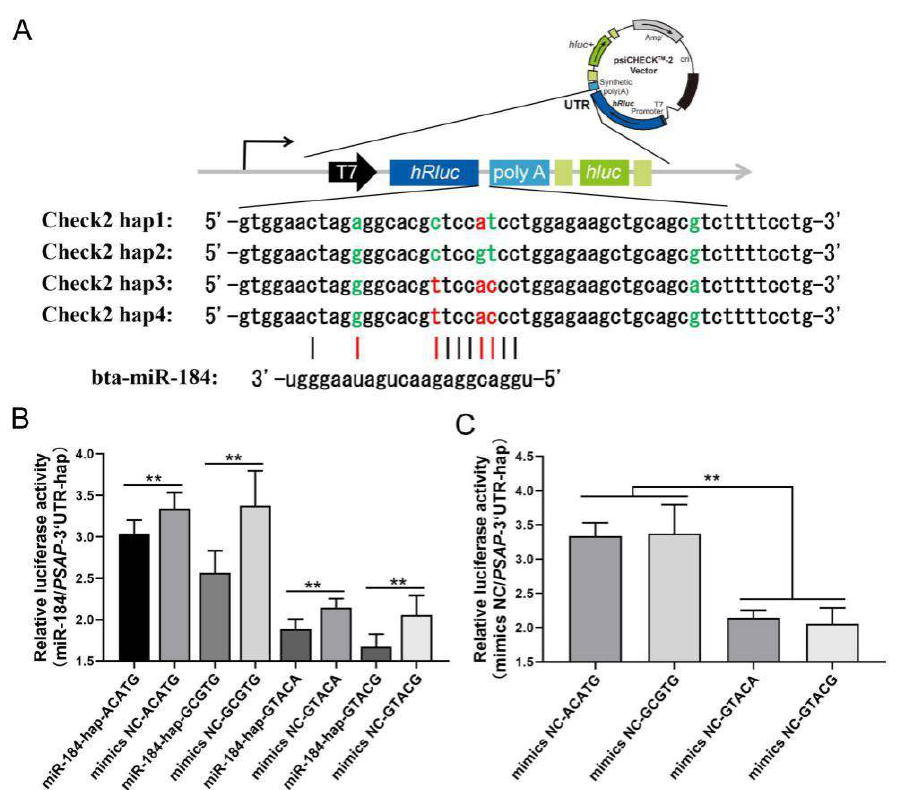
Figure 5. Targeting of bta-miR-184 and four haplotypes of bovine PSAP 3’ UTR. ( A ) Four haplotypes and their targeting of bta-miR184 (red represents mismatch and green represents match); ( B ) relative luciferase activity of four haplotypes and bta-miR-184; ( C ) relative luciferase activity of two haplotype groups. ** p < 0.01.